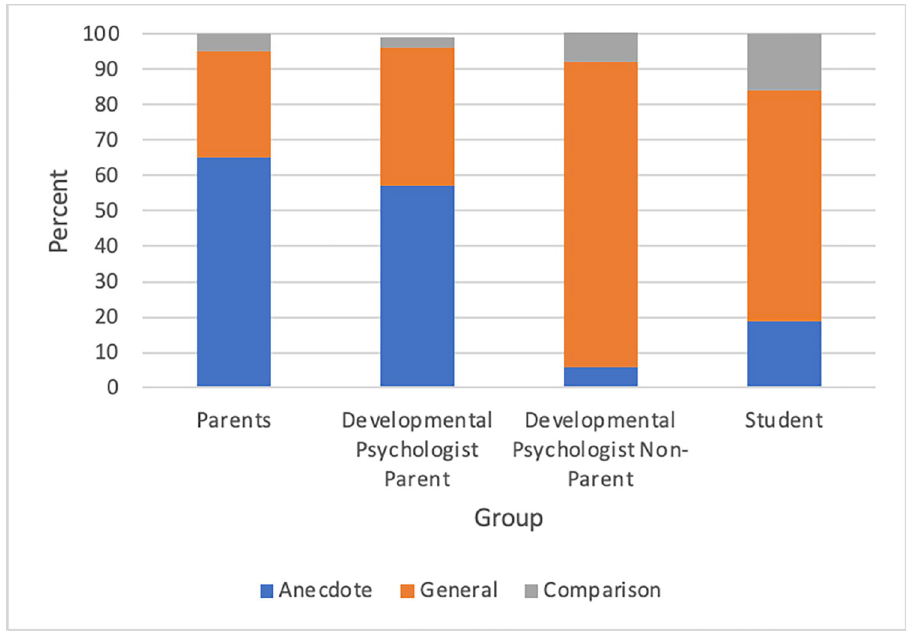
Fig 2. Participant statement types by